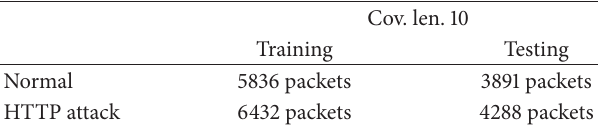
Table 3: Number of samples in cov. len. 10.